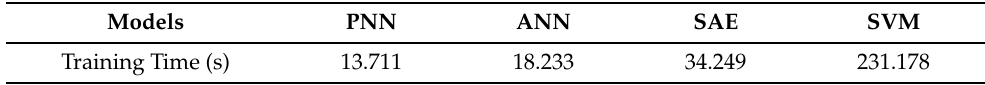
Table 4. Training times of different